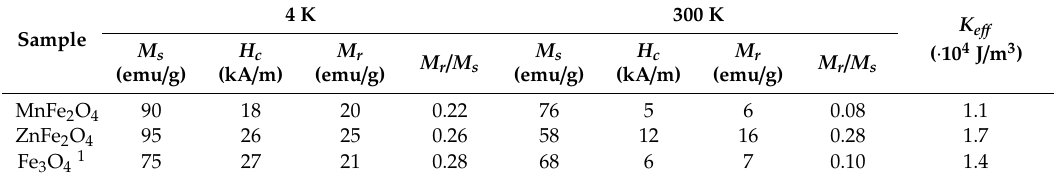
Table 1. Magnetic properties of MnFe 2 O 4 and ZnFe 2 O 4 compared to Fe 3 O 4 (synthesized in EG). Sample